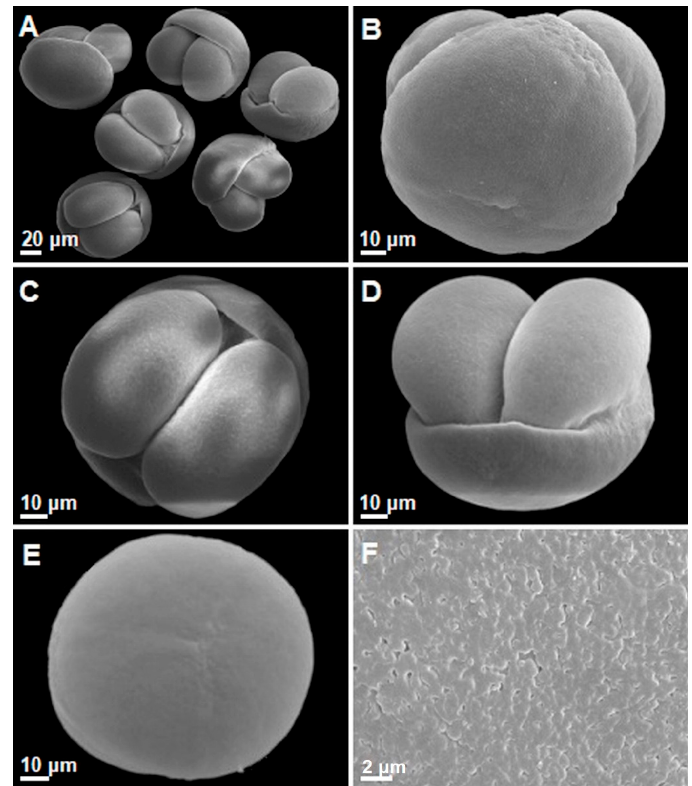
Figure 4. Pollen grains of Abies alba . ( A )—group of pollen grains in the polar and equatorial view, ( B )—polar proximal view, impression mark, ( C )—two sacci in polar distal view, ( D )—two sacci in equatorial view, ( E )—polar proximal view, and ( F )—psilate perforate exine surface.